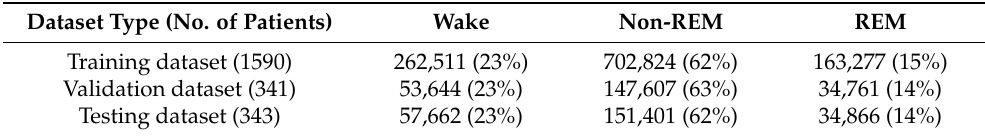
Table 1. Summary of